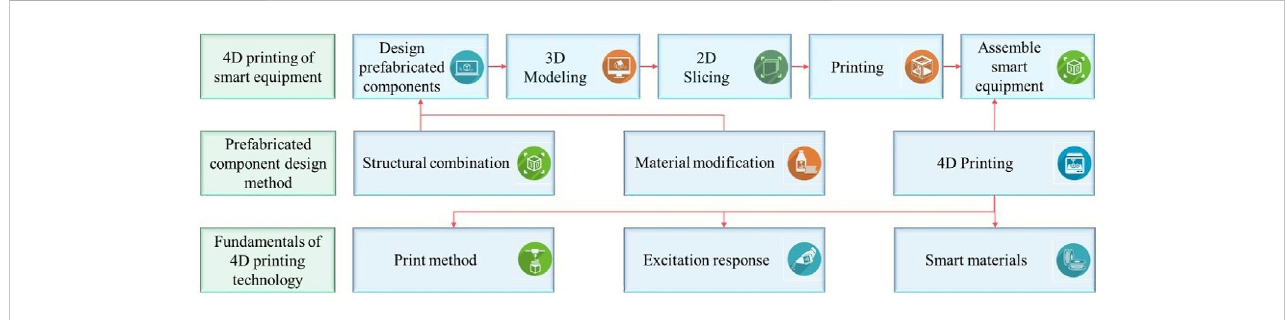
FIGURE 1 The technical overview of 4D printing prefabricated